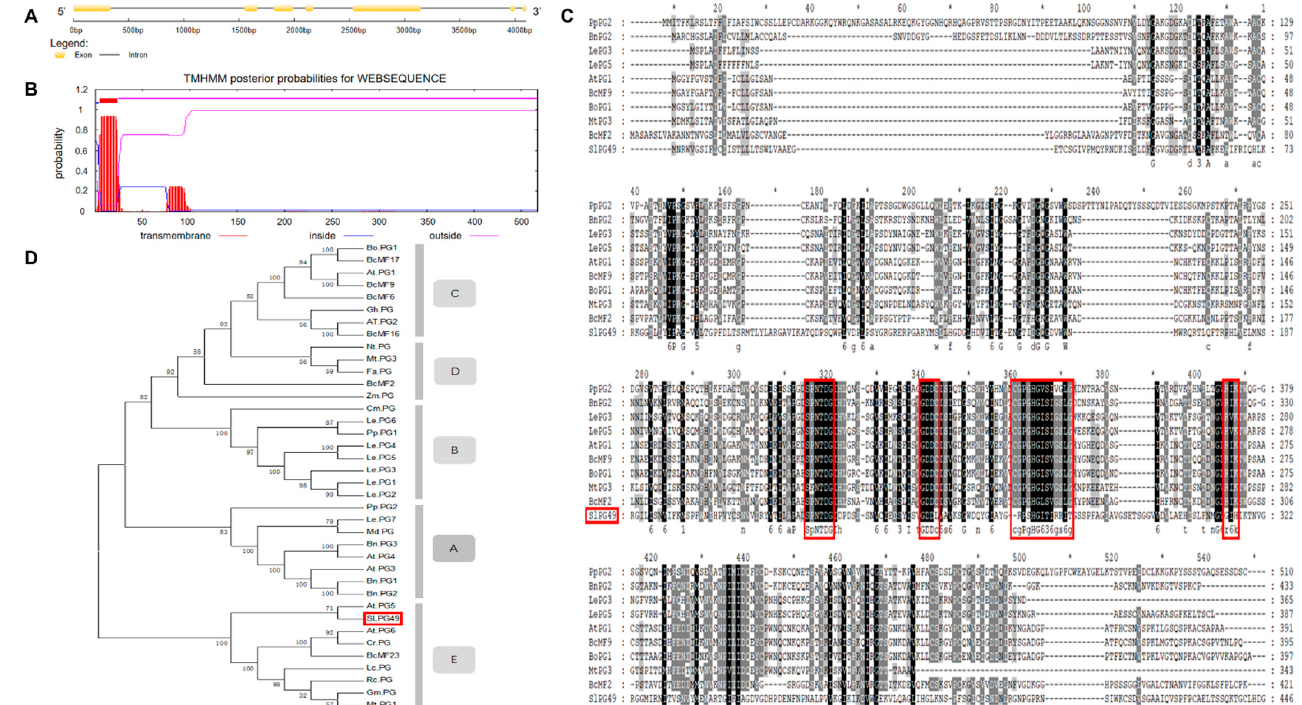
Figure 1. Gene structure, transmembrane region, multiple alignment, and phylogenetic analysis of SlPG49: ( A ) gene structure of SlPG49; ( B ) transmembrane region of SlPG49; ( C ) phylogenetic analysis of SlPG49; ( D ) multiple alignment analysis of SlPG49.